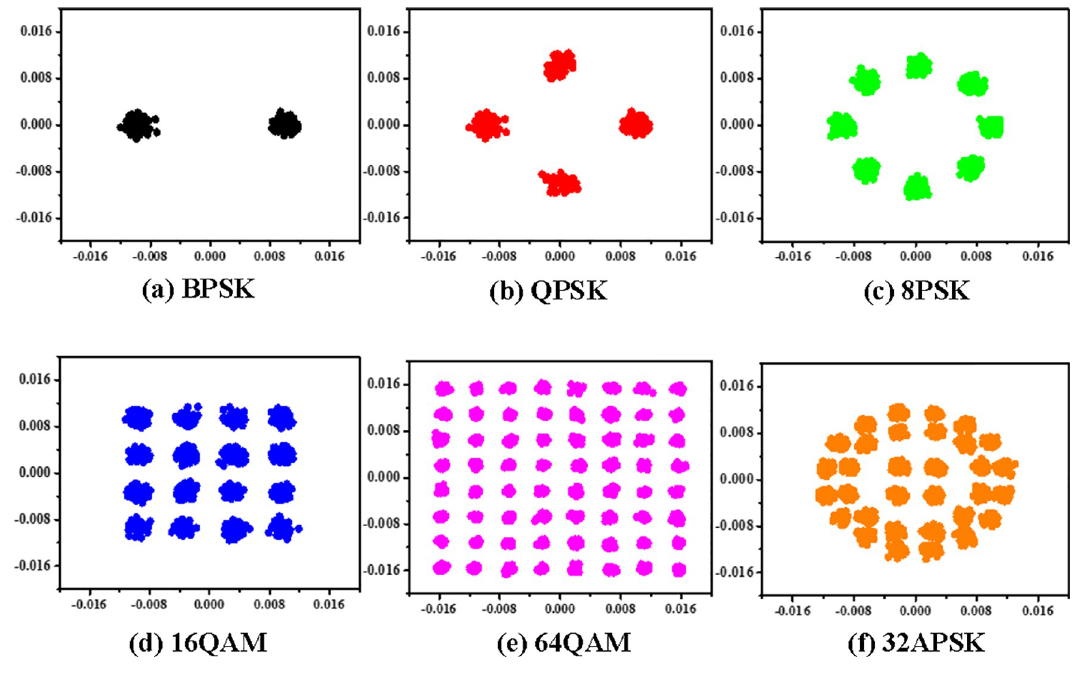
Fig 3. Constellation map of different modulation